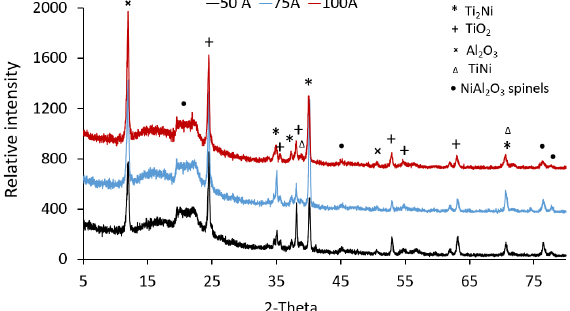
Figure 8. XRD analysis of Ti-6Al-4V samples coated with Ni / Al 2 O 3 -250 nm TiO 2 coating and surface melted as a function of welding current.